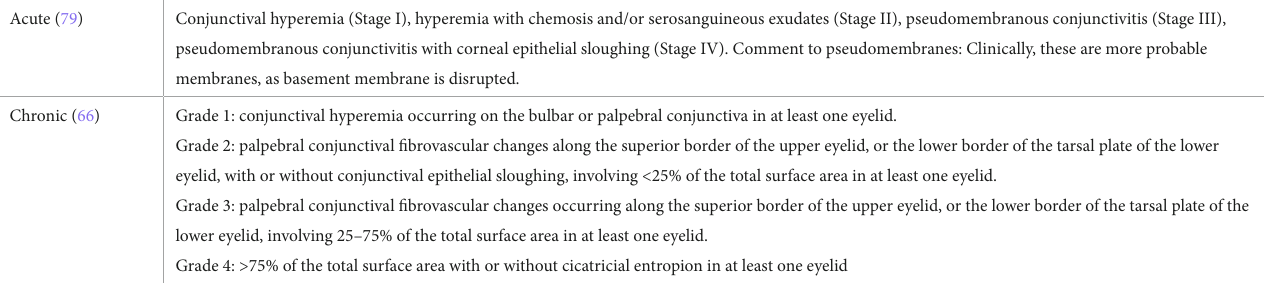
TABLE 4 Consensus Conference Proposal for diagnostic measures for assessment of ocular GVHD (75). Baseline examination after conditioning treatment and before HCT Visual acuity test, slit-lamp examination including subtarsal inspection and fluorescein